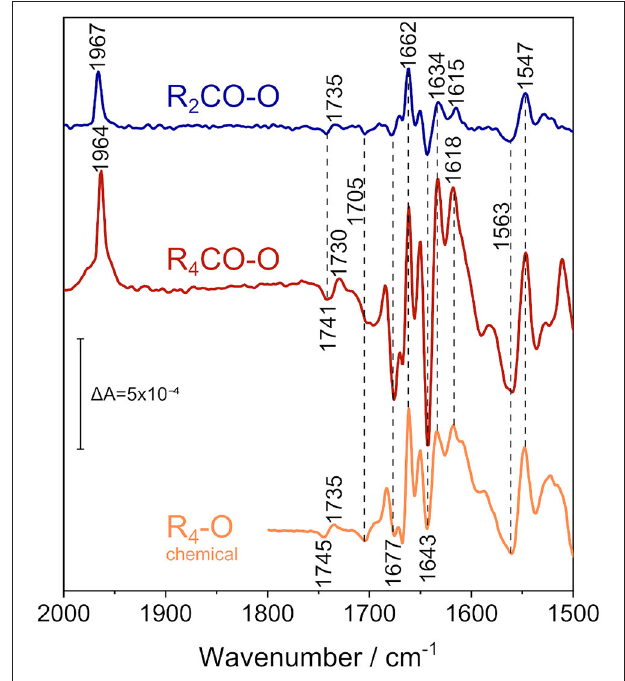
FIGURE 4 | ATR/FTIR difference spectra of the reduced states of CO-bound R. sphaeroides C c O reconstituted in 13 C-isotopically labeled lipids in D 2 O electrolyte buffer. Applying a potential of + 180mV vs. Ag/AgCl isolates the 2-electron-reduced state (R 2 CO, top spectrum, in blue), while fully reducing the enzyme at − 800mV vs. Ag/AgCl results in the 4-electron-reduced species (R 4 CO, middle, in red). CO and amide IR regions are shown. The data is compared to the perfusion-induced spectrum of fully reduced C c O in H 2 O, in the absence of CO (bottom spectrum, in orange, data taken from Nyquist et al., 2001 ). Band positions are labeled, and positions that do not differ between the states are highlighted by vertical dashed lines. The vertical marker shows the difference absorbance scale.